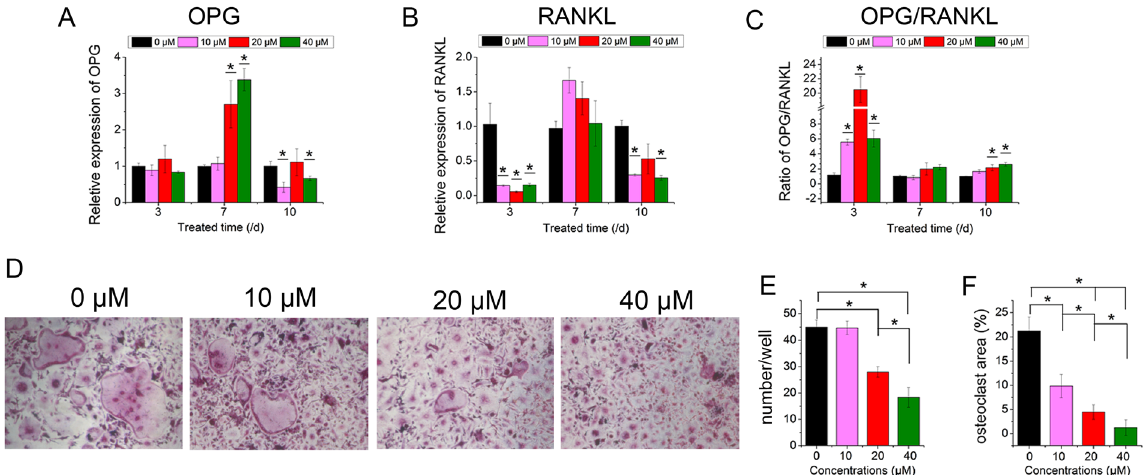
Figure 2. Effect of icariin on the expression of osteoclastic genes and formation of osteoclasts. ( A , B ) Real-time PCR analysis of OPG and RANKL mRNA in BMSCs treated with icariin at concentrations of 10, 20 and 40 µ M. ( C ) The ratio of OPG/RANKL. ( D ) Formation of osteoclasts. ( E ) Number of osteoclasts. ( F ) Area of osteoclasts. ( * p < 0.05, n =